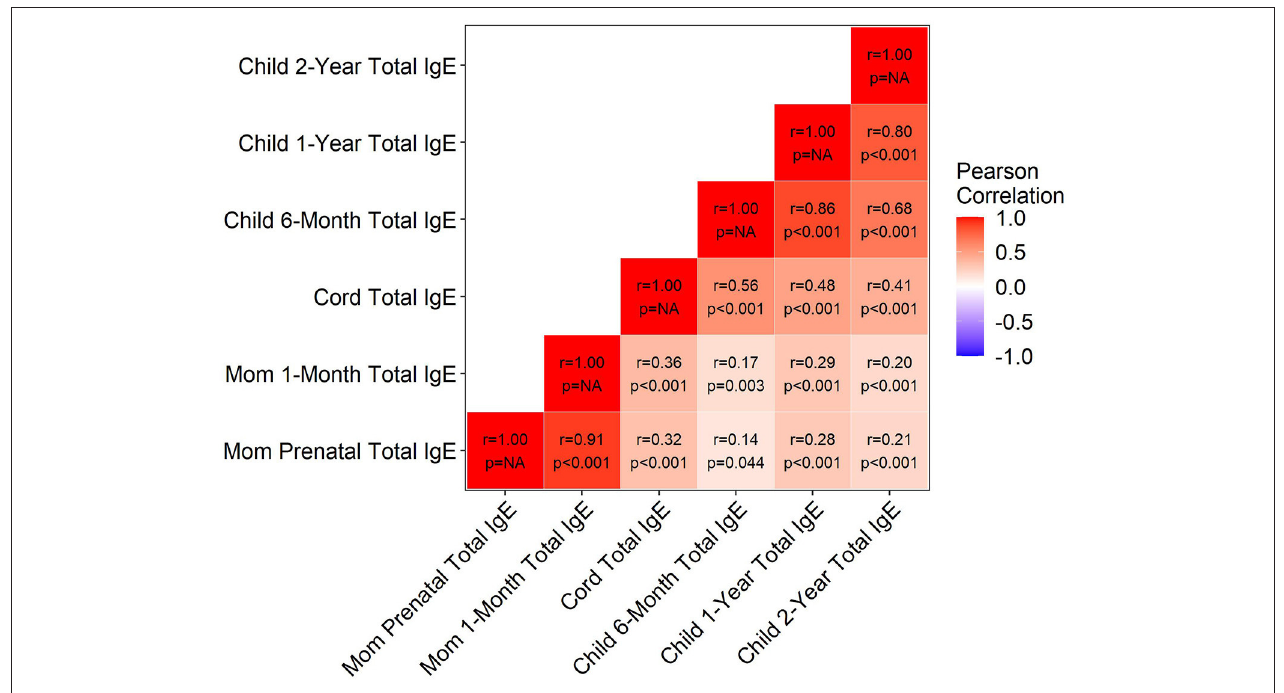
FIGURE 1 | Correlation between the maternal and child total IgE measurements. Ig, immunoglobulin.